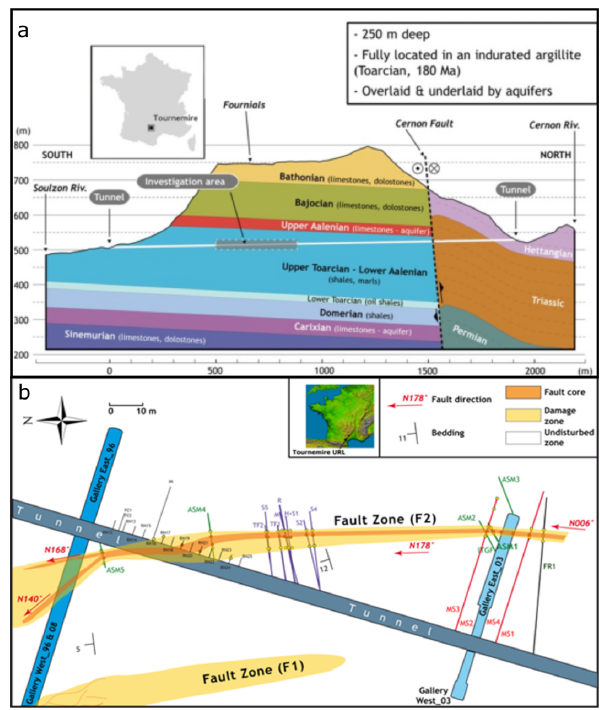
Figure 1. Overview of the Tournemire URL (after Lefèvre et al., 2016). (a) Cross section of surroundings of the tunnel; (b) Simpli- fied map of the Tournemire URL. The spatial distribution of the fault zones was determined from borehole logging and geological mapping from the galleries’ floor, walls, and roof. The three main components of the fault zones are: the fault core (represented in or- ange), the damage zone (represented in yellow), and the intact pro- tolith (represented in white). The fault core corresponds to the area of the fault zone where the majority of the displacement has taken place and includes gouge, cataclasites, kink bands, and subvertical schistosity. The damage zone forms a transition zone from the fault core to the protolith. The damage zone includes small faults, brittle fractures, and veins. The protolith denotes the non-deformed or non- fractured rock,non fractured (host) rock. The boundary between the protolith and damage zone is gradual while the boundary between the damage zone and fault core is